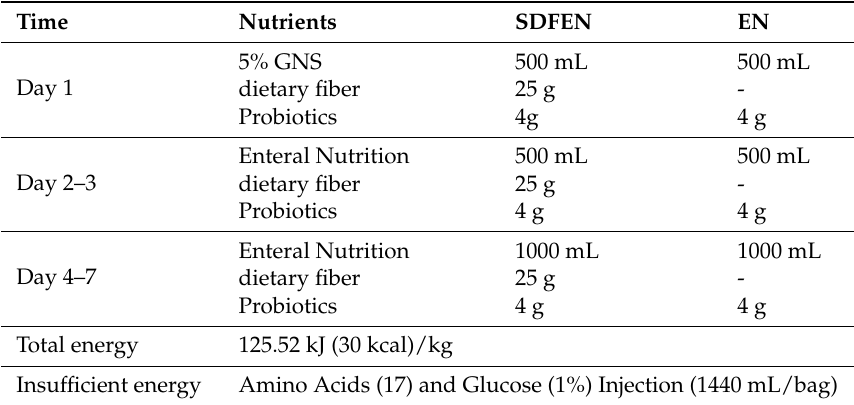
Table 1. Intervention of the cases and